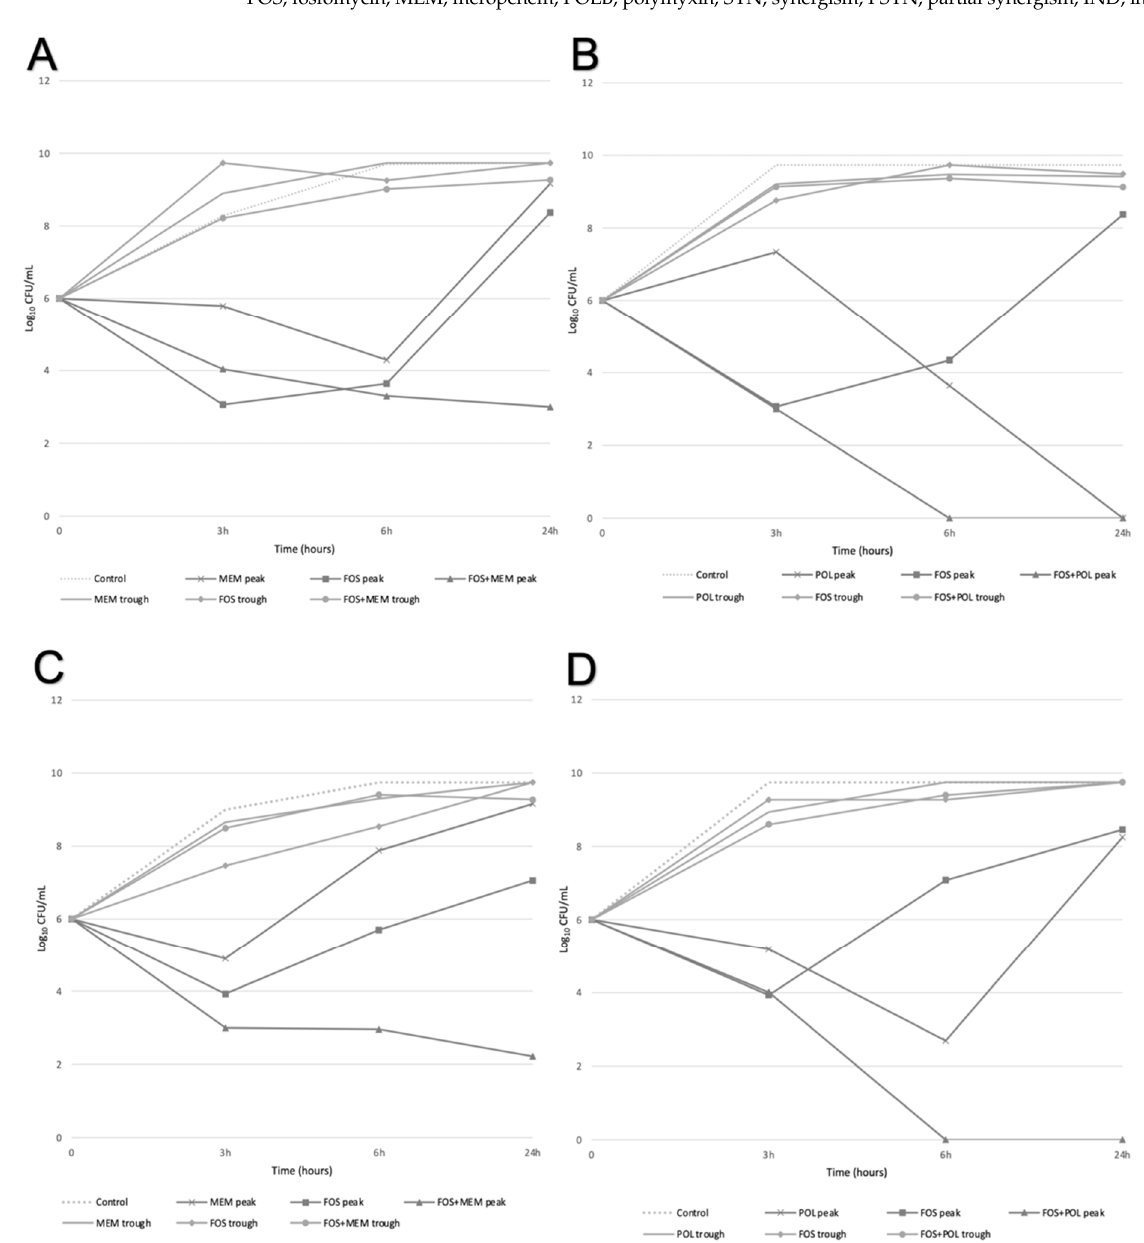
Figure 1. Representative time–kill curves under exposure to peak and trough concentrations of antimicrobials. This figure shows the time–kill curves of two representative isolates (HSP84 and HSP80) exposed to fosfomycin alone, meropenem alone, polymyxin B alone, fosfomycin + mero ‐ penem combination, and fosfomycin + polymyxin B combination. ( A ) Time–kill curves for isolate HSP84 under fosfomycin alone, meropenem alone, and fosfomycin + meropenem combination; ( B ) time–kill curves for isolate HSP84 under fosfomycin alone, polymyxin B alone, and fosfomycin + polymyxin B combination; ( C ) time–kill curves for isolate HSP80 under fosfomycin alone, mero ‐ penem alone and fosfomycin + meropenem combination; ( D ) time–kill curves for isolate HSP80 un ‐ der fosfomycin alone, polymyxin B alone and fosfomycin + polymyxin B combination. 2.3. In Vivo Synergism Assay The toxicity of antimicrobials alone or in combination, in trough and peak concentra ‐ tions, was tested against 10 larvae each. No evidence of toxicity was noticed because all larvae remained alive five days after.